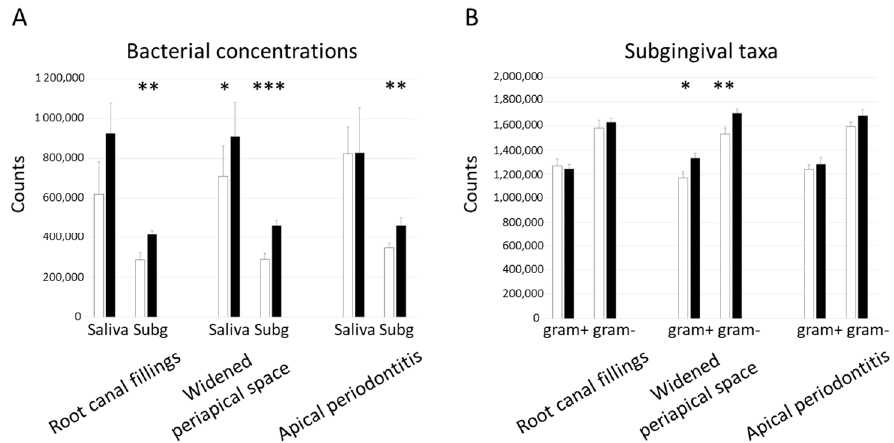
Figure 2. Saliva and subgingival bacteria according to endodontic findings. The patients were divided into groups according to the presence of root canal fillings, widened periapical spaces, and apical periodontitis. Salivary bacterial concentrations of A. actinomycetemcomitans , P. gingivalis , P. intermedia , and T. forsythia were determined by qPCR, and subgingival A. actinomycetemcomitans , P. gingivalis , P. intermedia , P. endodontalis , and T. forsythia by checkerboard DNA–DNA hybridization (A). This method was also used to examine subgingival 79 taxa, which were divided into Gram-positive ( n = 45) and Gram-negative ( n = 34) (B). The white columns depict the absence, and black columns presence of the endodontic finding. Means and standard errors are shown. The asterisks depict statistical significance between the groups defined by the t -test after logarithmic transformation: * p < 0.05, ** p < 0.01. *** p < 0.001.